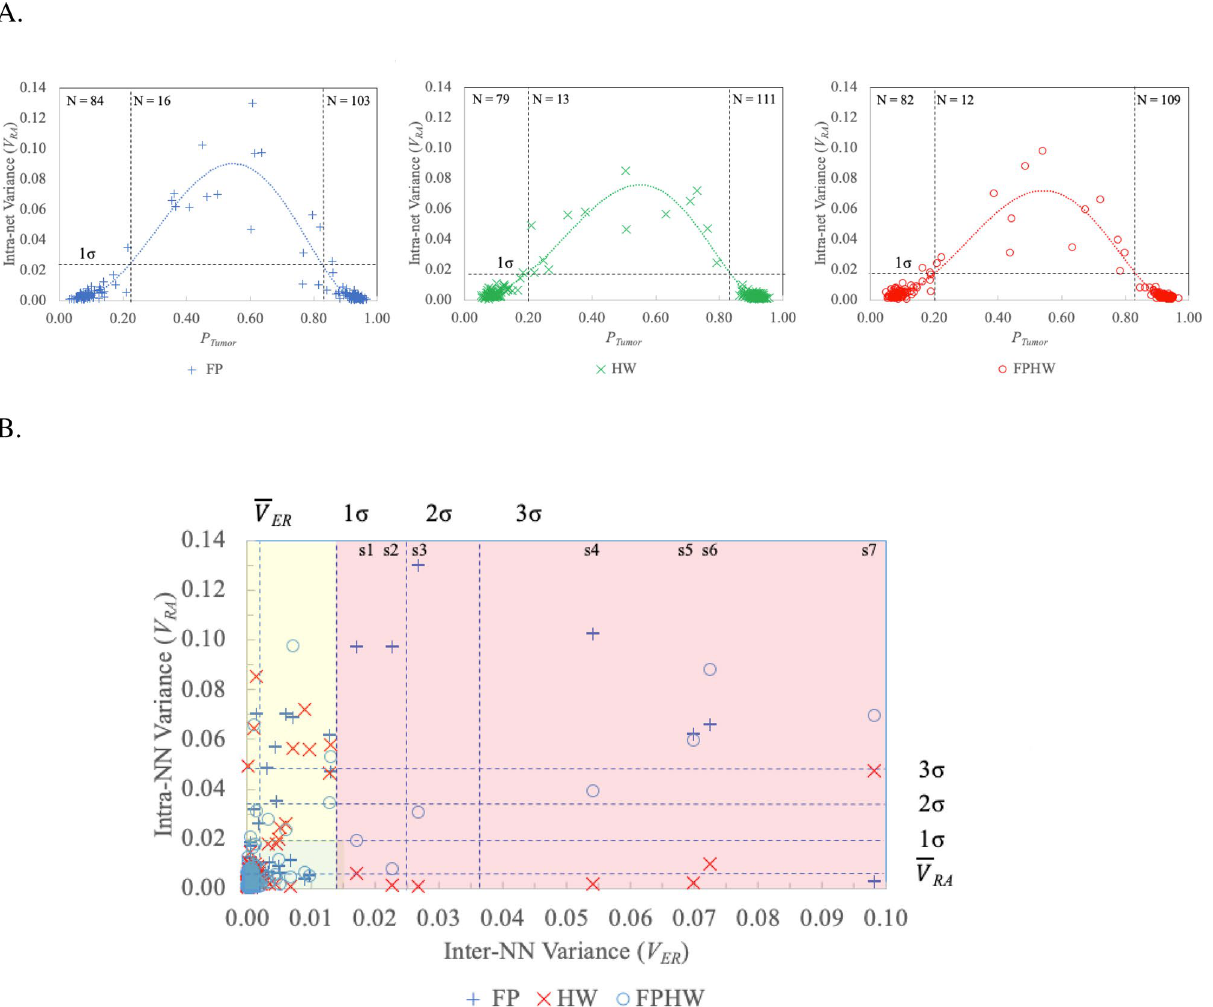
Figure 5. Characterizing the variation in the output of each stochastic NN (intra-NN variance or V RA ) and the differences in predicted tumor likelihood amongst the NN configurations (inter-NN variance, V ER ). The use of 3 configurations of stochastic NNs provides two useful variance estimates for assessing NN reliability and enhancing tumor detection likelihood estimates. The output variance of each stochastic NN when run through 10 complete train-test cycles with random weight resets for each cycle provides an intra-NN output variance estimate ( V RA ) for each of the three NN configurations. The lower the V RA , the more certain the NN is of its prediction. The inter-NN variance ( V ER ) is then calculated as the variance in the average output probabilities ( P Tumor , N = 10) generated by the 3 NN configurations while determining the V RA variance for each. V ER provides an immediate detection of disagreements in diagnostic predictions for the three NN configurations. ( A ) Depicts V RA for each of the three NN configurations as a function of P Tumor between the NN training boundaries ( P Tumor ~ 0 = > healthy, P Tumor ~ 1 = > tumor). P Tumor estimates are divided into those with V RA < 1σ and V RA > 1σ. Vertical dotted lines indicate the point where a 5 th order polynomial fit to the data intersects at the 1σ level. Significant increases in V RA ( V RA > 1 σ) appear as expected in the boundary zone between the two classes (i.e., ~ 0.2 < P Tumor < ~ 0.8). ( B ) Depicts V RA as a function of V ER . Significant inter-NN variance ( V ER > 1σ) occurred in 7 targets (shaded red), all from tumor or boundary regions. In six of the seven high V ER samples, the HW NN exhibits the least variance in its predictions (V RA between 0.001 and 0.10). For the other target (s7) FP exhibits the minimal variance across ten trials ( V RA ~ 0.003). Spectra corresponding to these 7 targets appear in Fig. 6. See Table 6 for a comparison of the cancer probability predictions and the NN variances. Another 17 targets (yellow shading) exhibit high V RA (> 1σ), but low V ER (< 1σ). See Table S2 in Supplementary